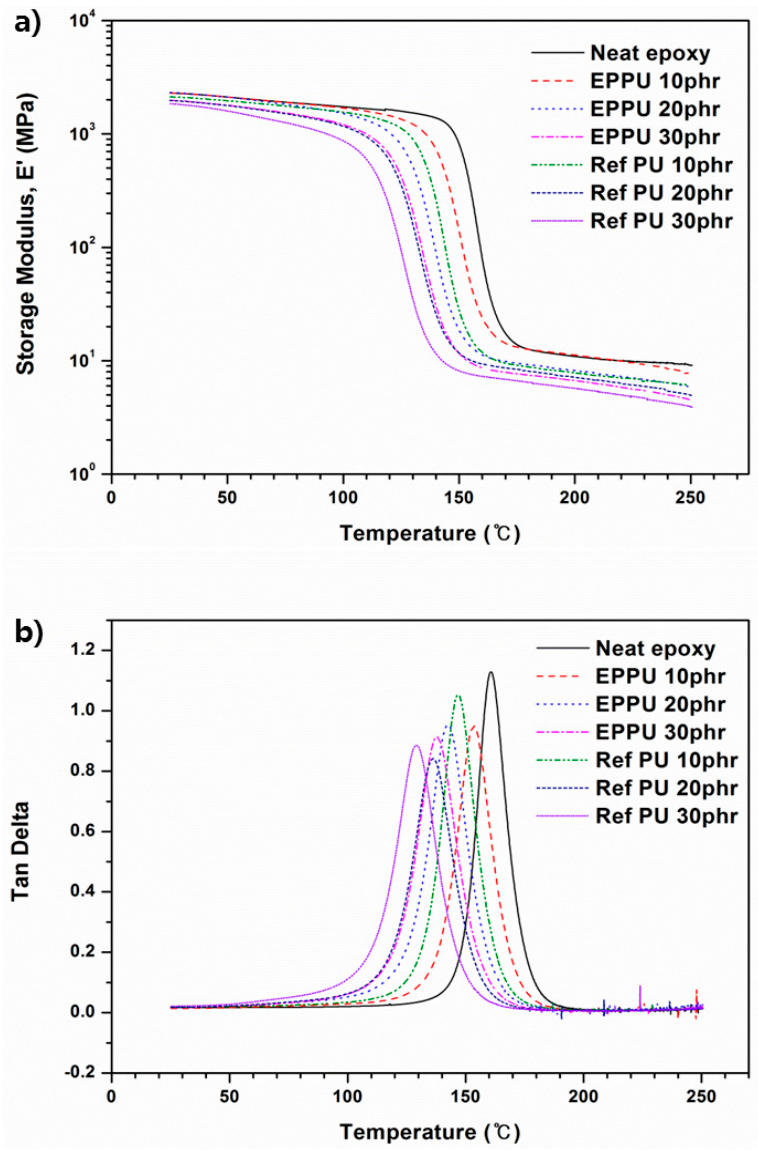
Figure 9. ( a ) Storage moduli of epoxy compositions and ( b ) tan δ values. Table 4. Storage moduli and V c of epoxy compositions containing PUs. phr: parts per hundred resin; DMA: dynamic mechanical analysis.